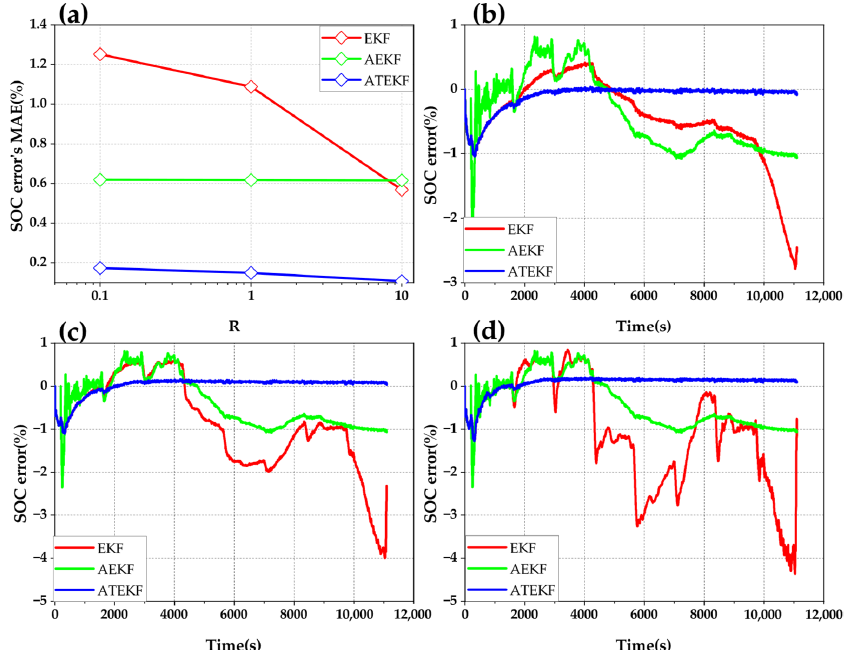
Figure 12. SOC error of three algorithms under different measurement noises: ( a ) MAEs of EKF, AEKF, and ATEKF under different measurement noises; ( b ) SOC error comparison of EKF, AEKF, and ATEKF with R = 10 × eye ( 2 ) ; ( c ) SOC error comparison of EKF, AEKF, and ATEKF with R = 1 × eye ( 2 ) ; ( d ) SOC error comparison of EKF, AEKF, and ATEKF with R = 0.1 × eye ( 2 ) .